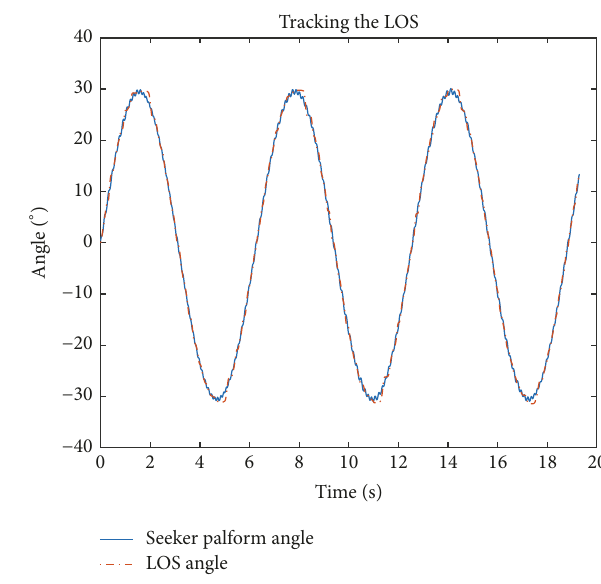
Figure 26: Seeker platform angle and LOS